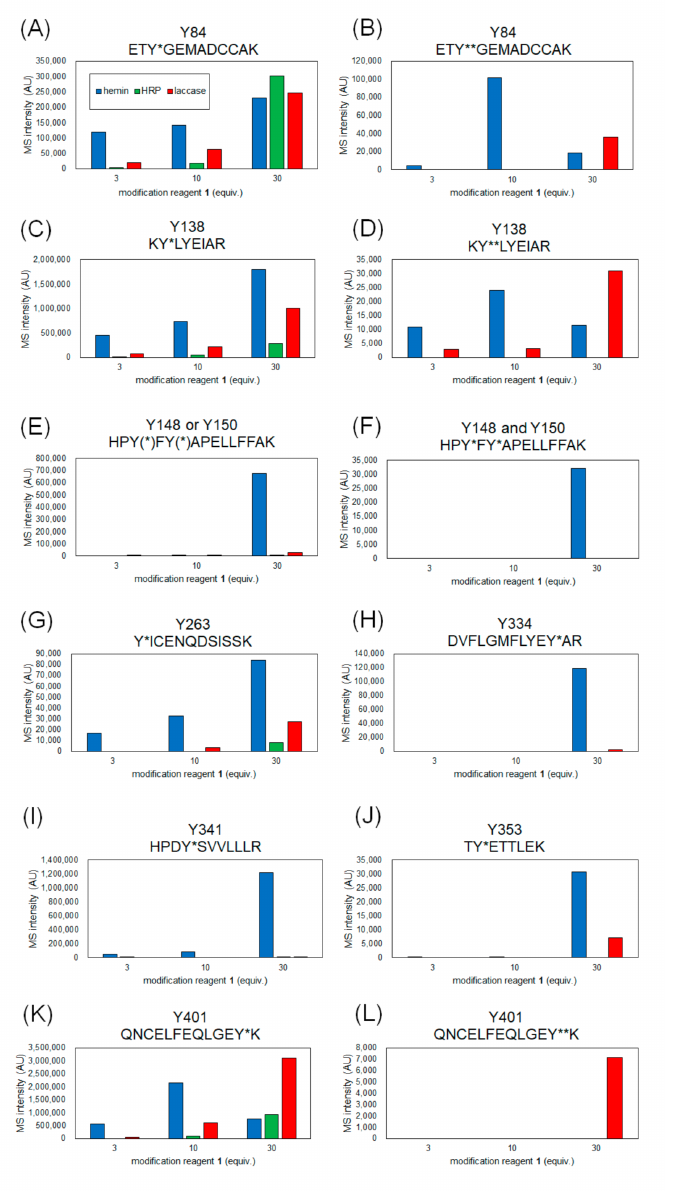
Figure 3. MS intensity comparison of modified peptides containing each tyrosine residue. Y* and Y** indicate single and double modified tyrosines with 1 . Peptide fragment containing modified Tyr84 ( A ), Tyr138 ( C ), Tyr148 or/and Tyr150 ( E , F ), Tyr263 ( G ), Tyr334 ( H ), Tyr341 ( I ), Tyr353 ( J ), Tyr401 ( K ) and double-modified Tyr 84 ( B ), Tyr138 ( D ), Tyr401 ( K , L ).